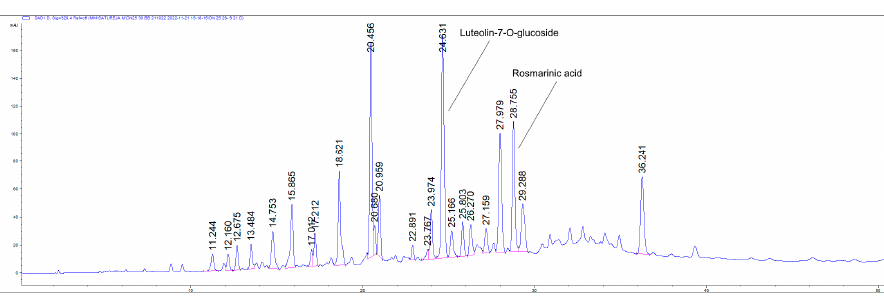
Figure 1. Chromatogram of an extract (Run 21) recorded at 320 nm. Table 1. Chromatographic parameters for HPLC method for determination of phenolic compounds in Satureja montana extracts.